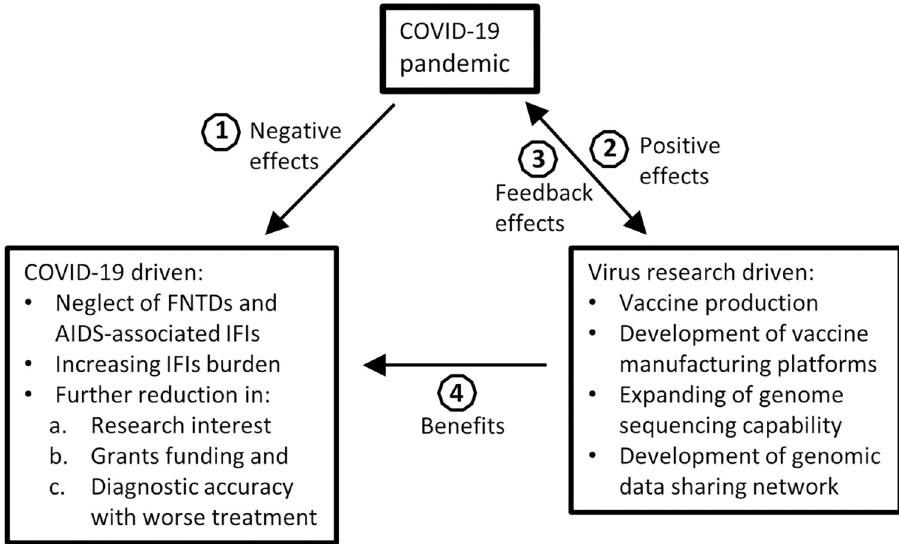
Fig 1. Lessons learned from COVID-19 pandemic influence on IFIs. In endemic regions, IFIs, malaria, HIV, and TB are common due to poverty. However, due to limited awareness, and low research funding, limited rapid and accurate diagnostics, and effective therapeutic options, compared to malaria, HIV, and TB, IFIs have not received adequate priority despite their high prevalence. (1) Negative effects of COVID-19 on IFIs: The emergence of COVID-19 pandemic attracted all medical attention, resources and funding for emergency response and containment, and research; thereby, it is assumed to exacerbate the existing conditions of IFIs and increase burden. (2) Positive effects of COVID-19 response: Through sheer ambition and strategic investment including contributions from donors such as Illumina, Oxford Nanopore, Microsoft, and Gates Foundation, African governments have pledged to expand vaccine production and strengthen vaccine substance manufacturing capacity to meet with up to 60% of local vaccine needs in the next 2 decades. The response to COVID-19 also stimulated expansion of capacity and expertise in next-generation sequencing technology and deepened collaboration in genomic data sharing networks through African Pathogen Genomics Initiative. (3) Feedback effects: These technologies and networks are now used in surveillance of SARS-CoV-2 evolution to tackle new threats. (4) Benefits: The virus-driven development in genome sequencing and vaccine manufacturing technologies and genomic data sharing network have wide application and can be used to drive research in IFIs and other neglected infections through collaborative efforts. COVID AU : TheabbreviationlistinFig 1 hasbeenupdated : Pleaseverifythattheaddedentriesarecorrect : -19, Coronavirus Disease 2019; FNTD, fungal neglected tropical disease; IFI, invasive fungal infection; SARS-CoV-2, Severe Acute Respiratory Syndrome Coronavirus 2; TB,